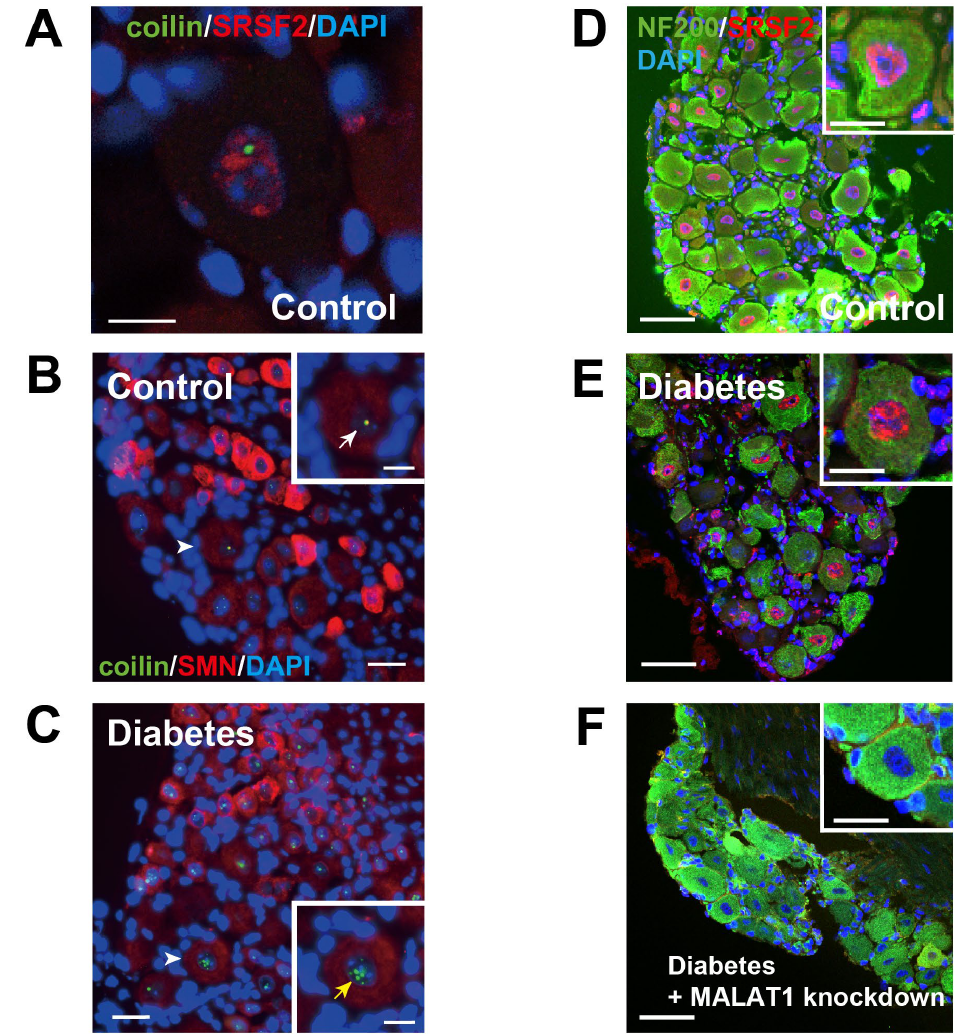
Figure 2. The structural alternations of nuclear bodies in DPN. In non-diabetic DRG sensory neurons, a single CB (coilin) was in contact with a nucleolus (DAPI), and nuclear speckles (SRSF2) were located in the interchromatin regions of the nucleoplasm in controls ( A ). Scale bar: 10 µ m. In non-diabetic DRG sensory neurons, SMN protein was distributed throughout the cytoplasm and as nuclear foci ( B ); Scale bars: 20 µ m, 10 µ m in insets. SMN nuclear foci that collaborate on the assembly of snRNPs were localized within CBs (coilin) in controls (middle row, white arrows) but numerous CBs lost co-localization with SMN nuclear foci (bottom row, yellow arrow) in diabetic nuclei ( C ). Scale bars: 20 µ m, 10 µ m in insets. Arrowheads indicate sensory neurons magnified in the insets. SRSF2 is expressed in the nuclear speckles, where MALAT1 is localized, in the DRG sensory neurons in non-diabetic control mice. Anti-neurofilament 200 (NF200) is a marker of large and small myelinated neurons ( D ). DRG neurons with SRSF2-positive nuclear speckles are moderately reduced in the diabetic mice ( E ); They are further decreased in diabetic mice with MALAT1 silencing ( F ). Scale bars = 50 µ m, and 20 µ m, in insets. ( A – C ) were adapted with permission from Ref. [41]. 2017 Zochodne, D.W. and ( C – F ) from Ref. [44]. 2022 Yokota, T.